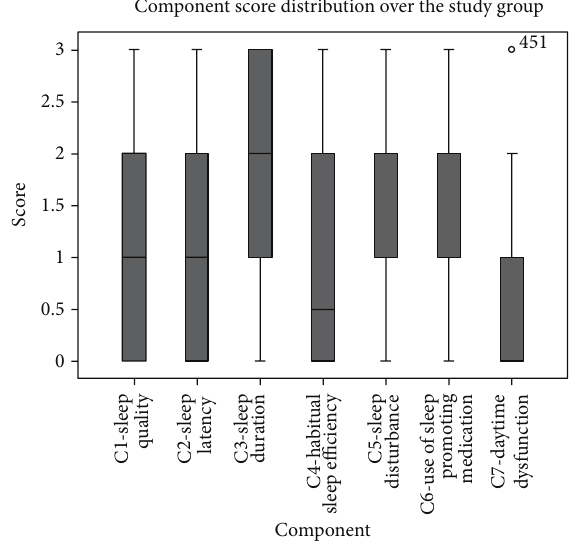
Figure 3: Individual sleep component analysis. Patients demon- strated sleep dysfunction in all 7 subcategories. Sleep duration, sleep disturbance, and use of sleep promoting medications were the parameters greatest effected. Bars indicate 95% min and max